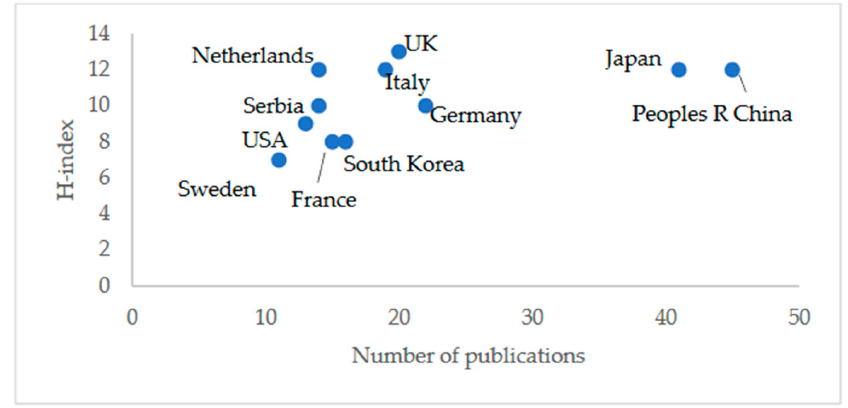
Figure 6. The top 11 productive countries (TP ≥ 10).